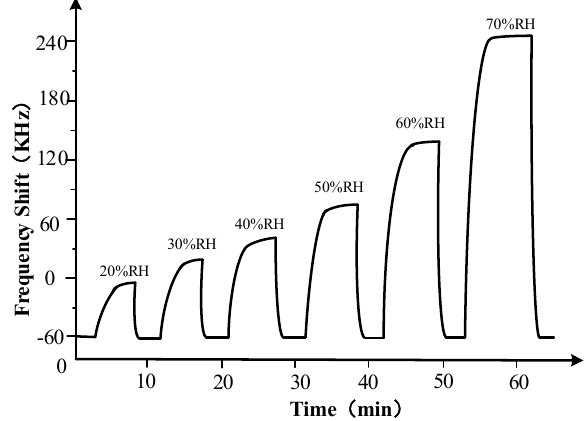
Figure 12. Humidity response characteristics of the Love wave humidity sensor.